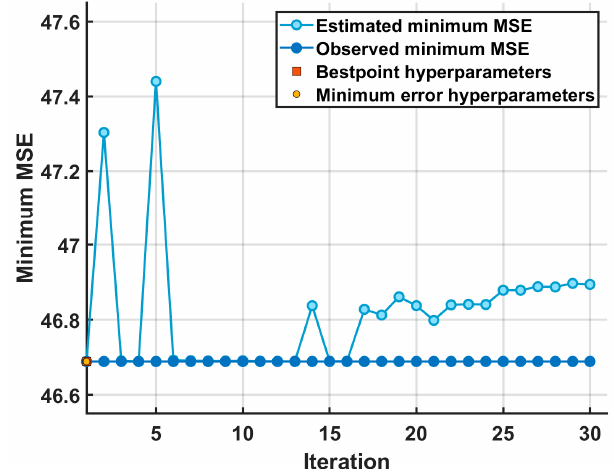
Figure 5. MSE optimization plot of the DT model.